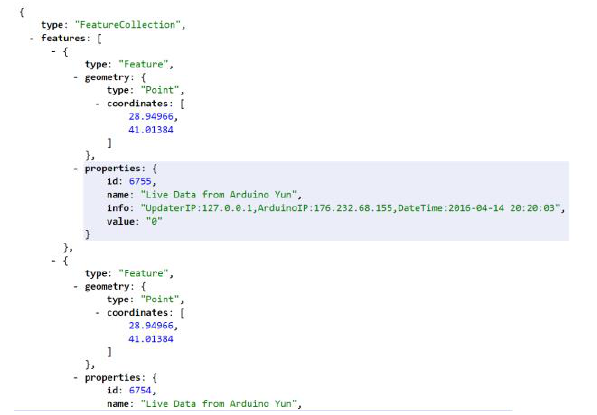
Figure 8. GeoJSON representation of features in Neo4J database